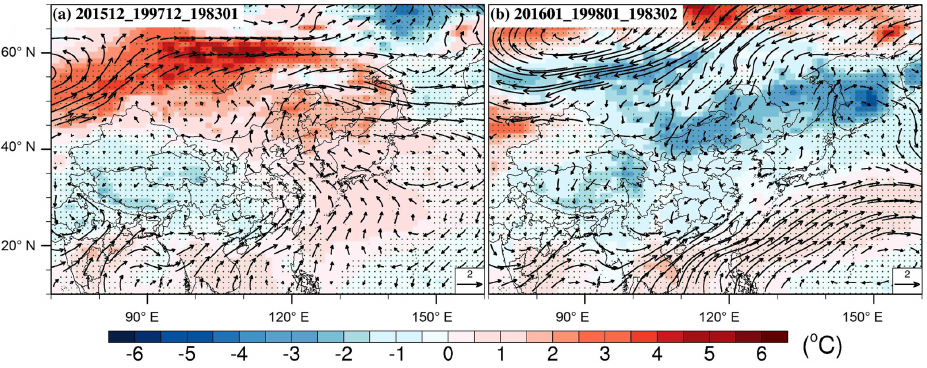
Figure 4. 850hPa wind anomaly (unit: ms − 1 ) and 2m air temperature anomaly (relative to 1987–2016). The anomaly was conducted over the respective month from 1987 to 2016, i.e., the mean value of the anomaly over December 2015, December 1997 and January 1983 (a) and over January 2016, January 1998 and February 1983 (b) . Stippled areas indicate 2m air temperature exceeding the 90th confidence interval (the same method as Fig.